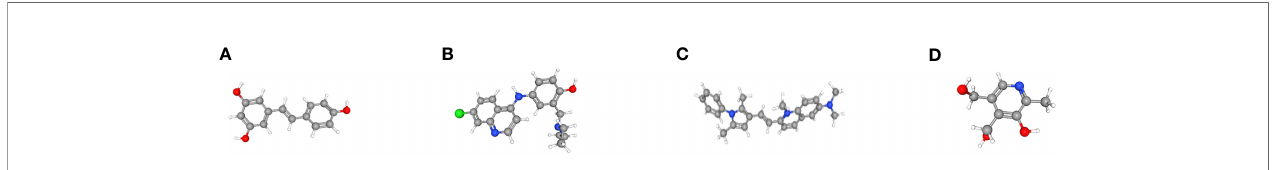
FIGURE 9 | The 3D structure of the four small molecule drugs for OC. (A) resveratrol, (B) amodiaquine, (C) pyrvinium, and (D) pyridoxine.